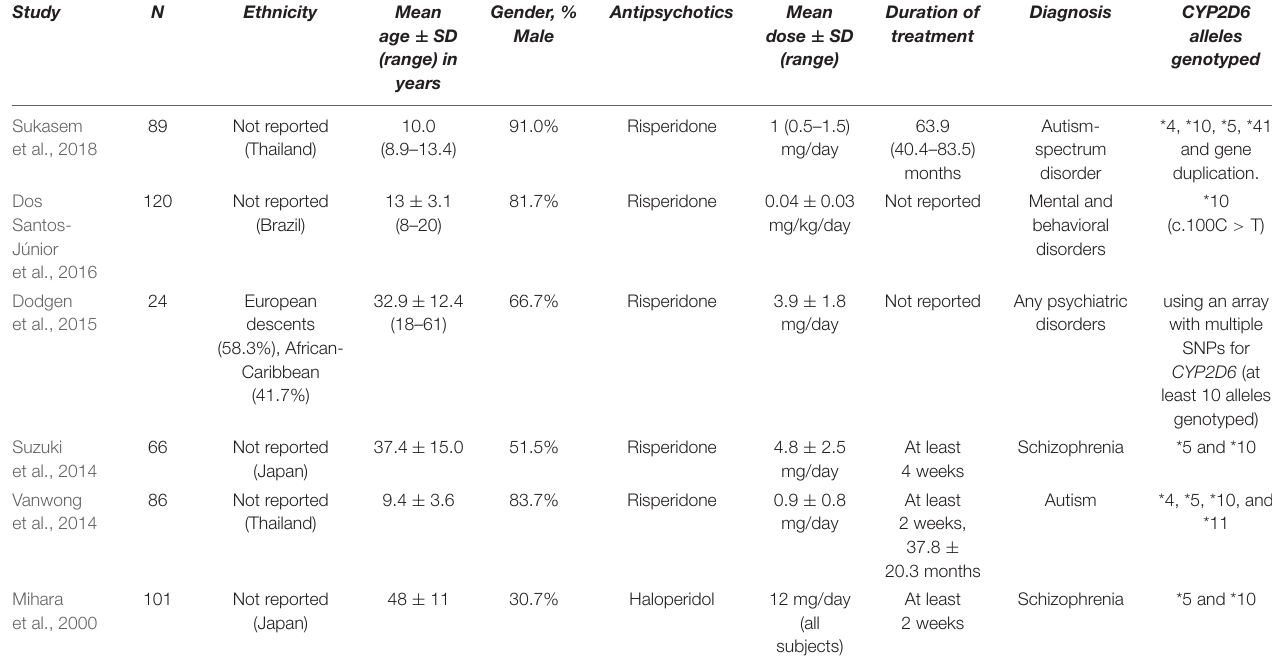
TABLE 2 | The characteristics of the cross-sectional observational studies included in the systematic review.